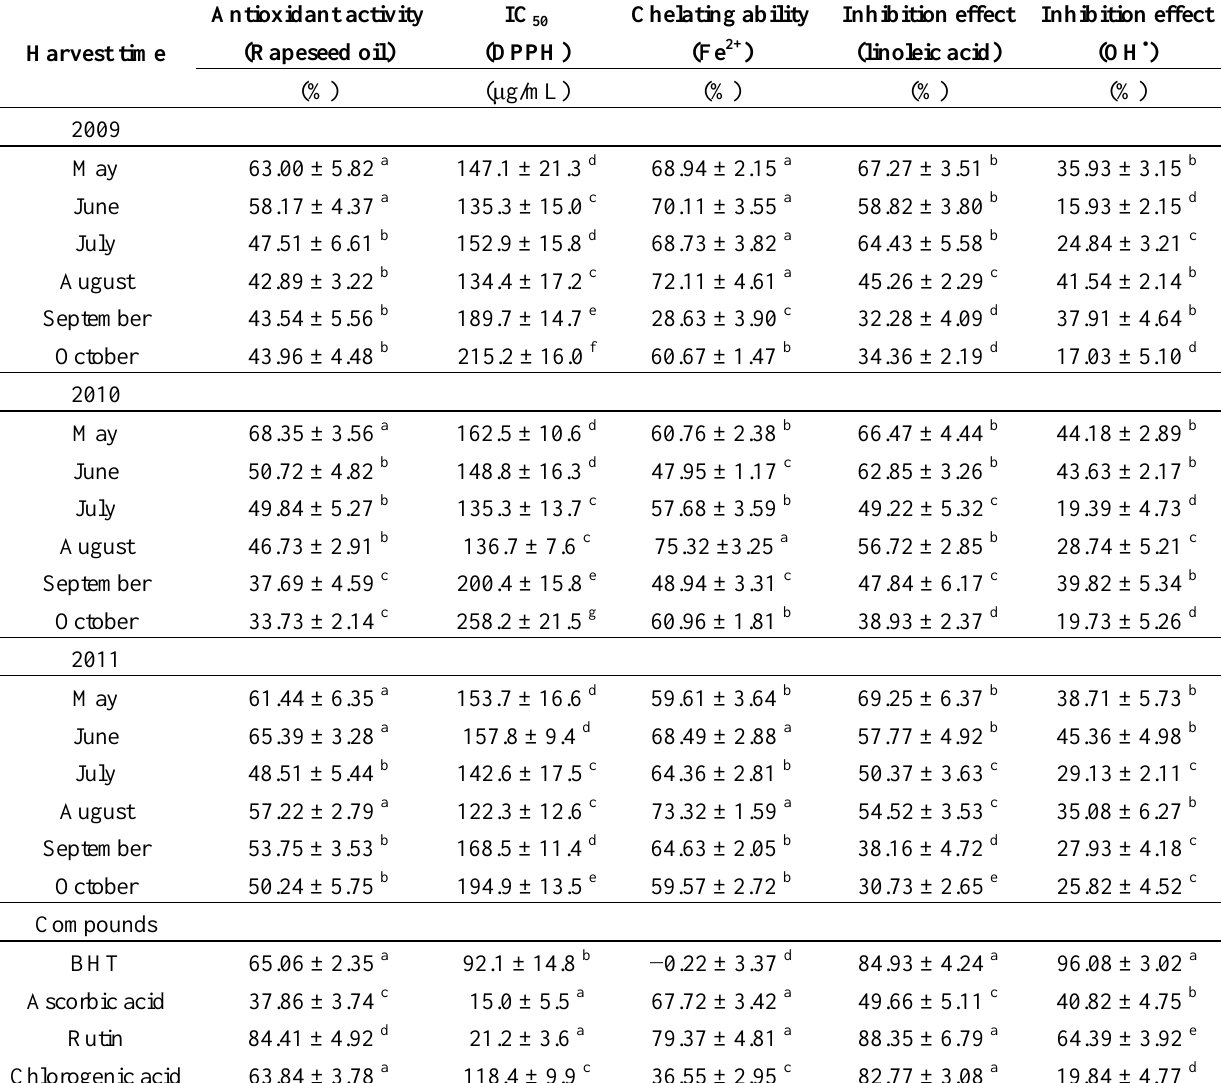
Table 2. Antioxidant effects of EU leaves collected at different